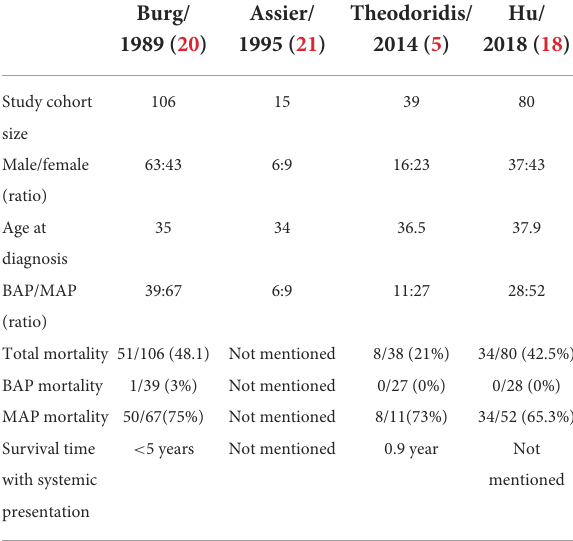
TABLE 2 Demographic and clinical data of four previous